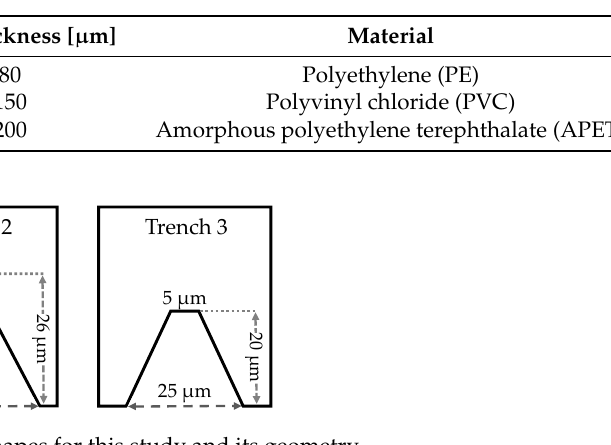
Figure 3. Three different trench shapes for this study and its geometry.